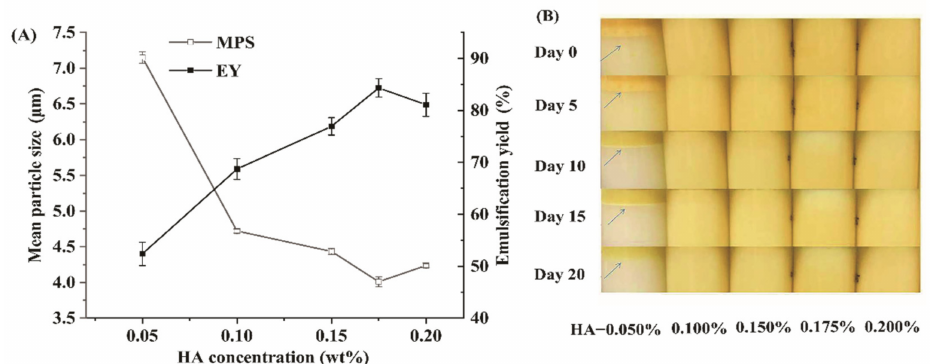
Figure 1. HA concentration’s effect on the MPS and EY ( A ) and storage stability ( B ) of HA-stabilized β -carotene emulsion during 20 days of storage.